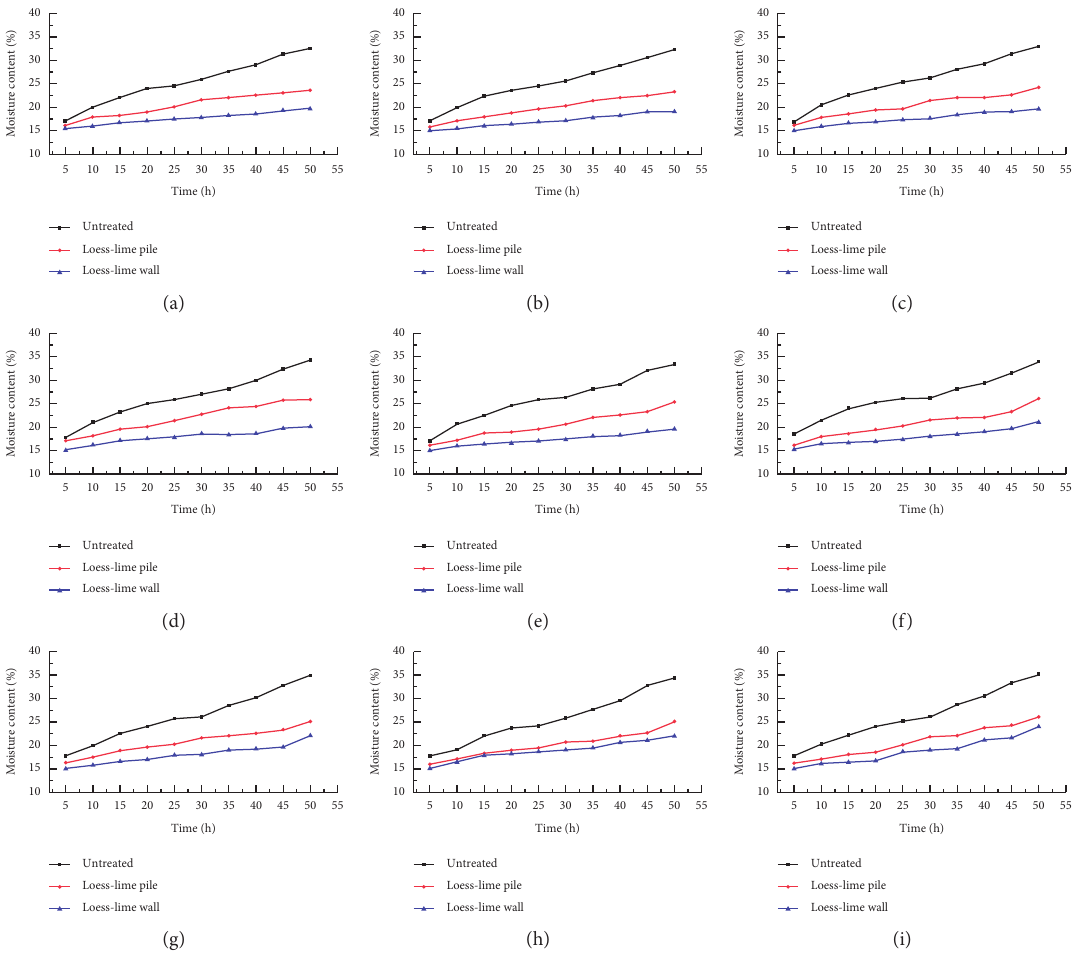
Figure 5: Changes in water content of each monitoring point over time. (a) Sensor no.1. (b) Sensor no. 2. (c) Sensor no. 3. (d) Sensor no. 4. (e) Sensor no. 5. (f) Sensor no. 6. (g) Sensor no. 7. (h) Sensor no. 8. (i) Sensor no.